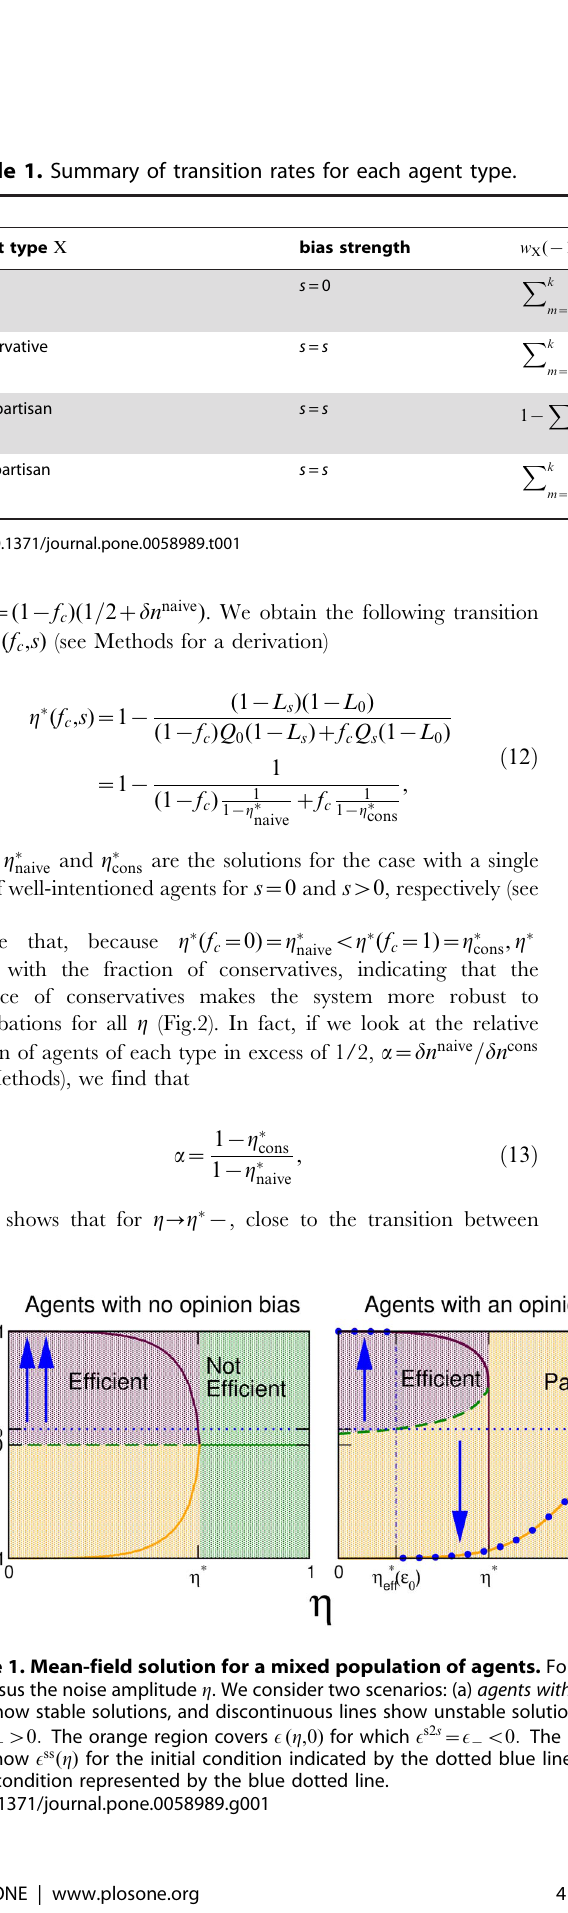
Table 1. Summary of transition rates for each agent type.